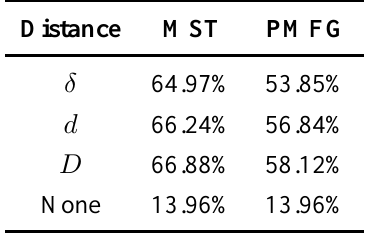
Table 1. Percentage of links between instruments belonging to the same economic sector in all links within the studied networks. As a reference, the same is shown for an unrestricted network or a full graph. Both mutual information ( d ) and partial mutual information ( D ) reproduce the sector structure from price changes slightly more accurately than Pearson’s correlation coefficient ( δ ), which is in agreement with similar studies of other markets. MST, minimally-spanning tree; PMFG, maximally-filtered